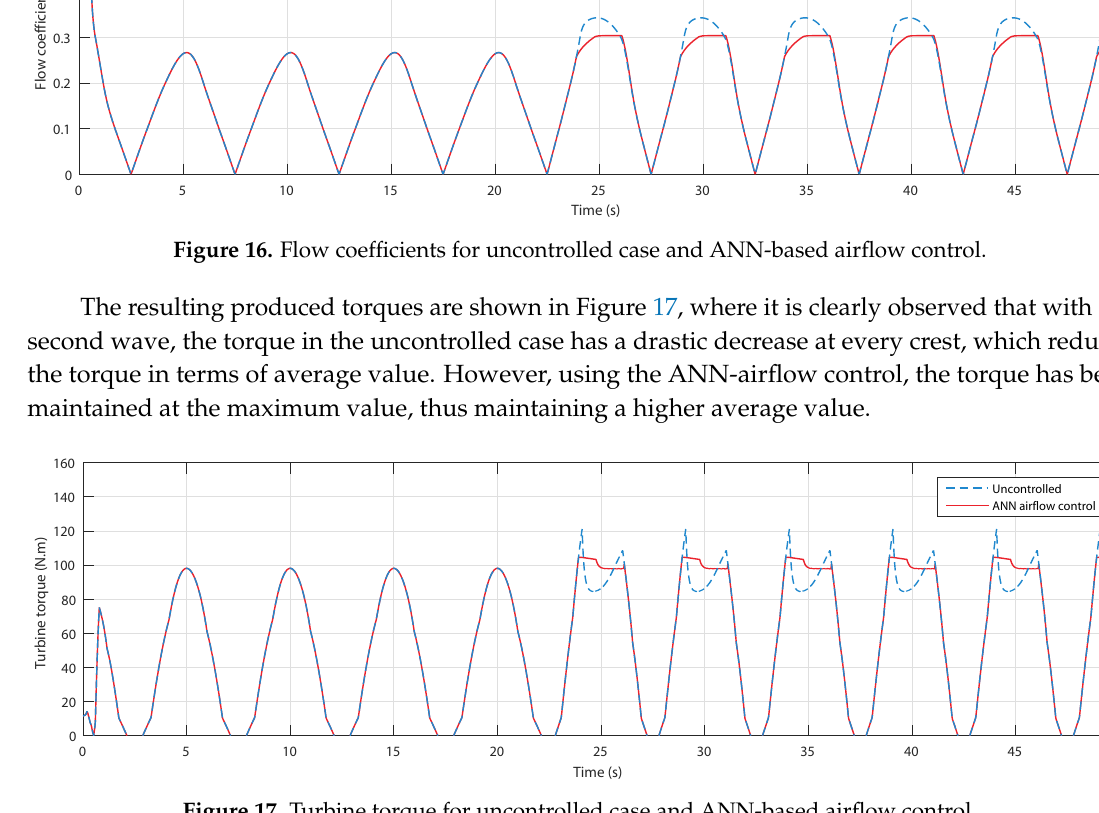
Figure 17. Turbine torque for uncontrolled case and ANN-based airflow